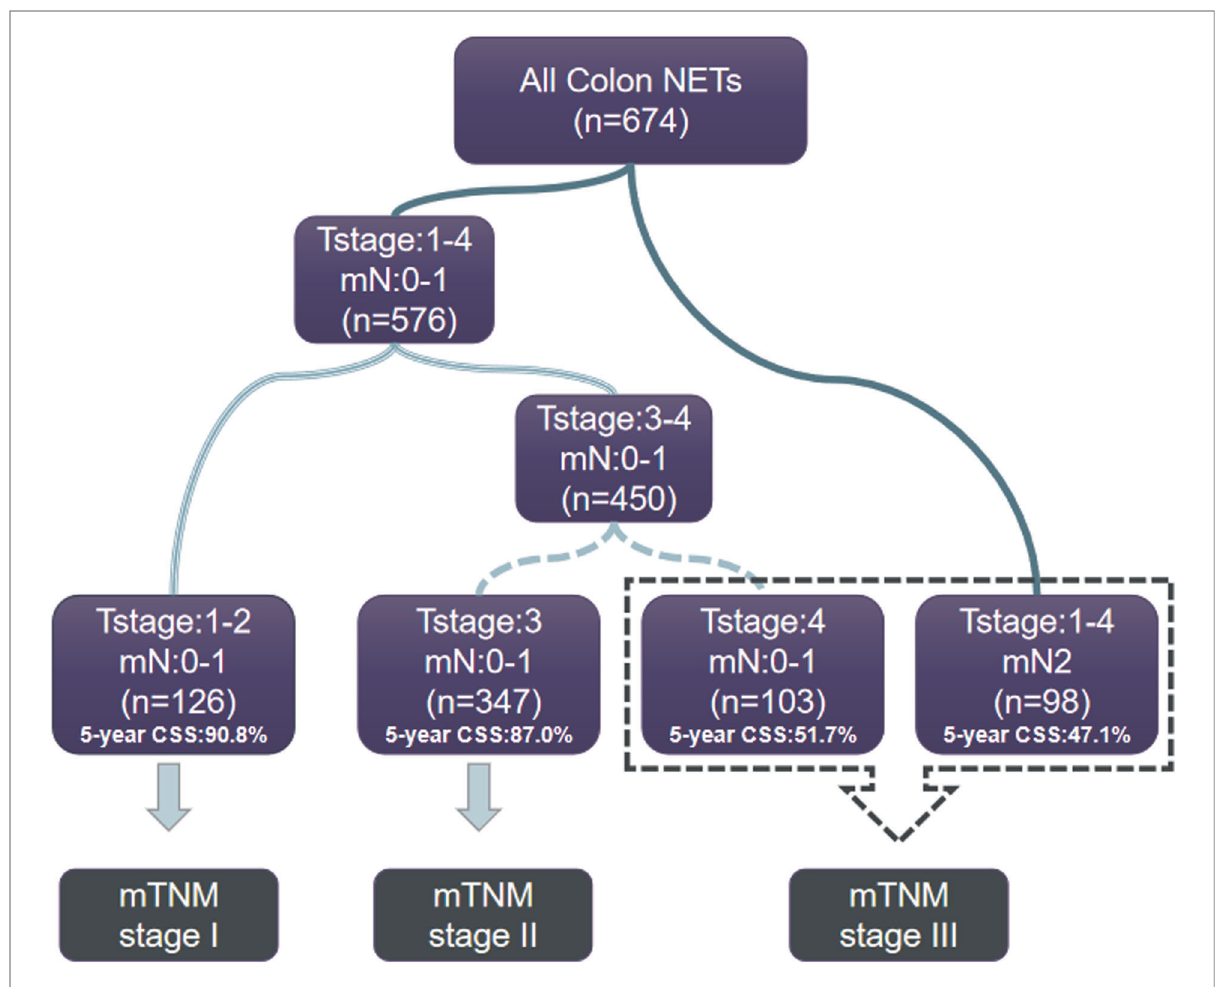
FIGURE 4 The proposed risk grouping derived by RPA. RPA, recursive partitioning